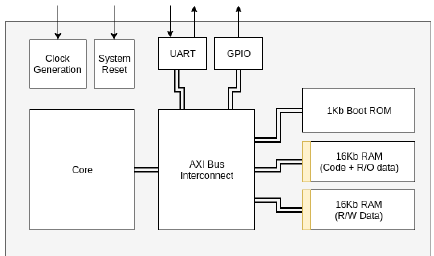
Figure 3: A block diagram of the SoC, allowing a uniform interface to either the PicoRV32 or SCARV